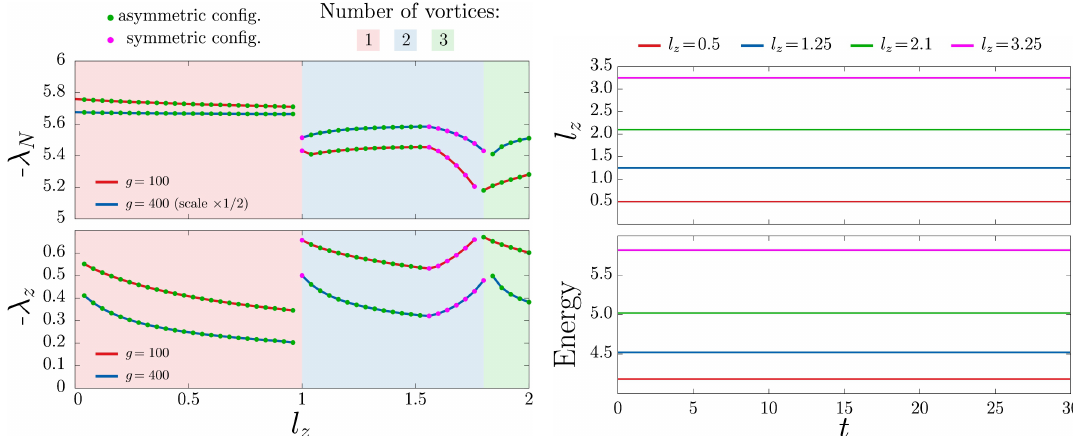
Figure 5 . Details of the results of simulations where the particle number is N = 1 . The dependence of the Lagrange multipliers on the constrained angular momentum l z are displayed on the leftmost panel. The right panels illustrate that the time-evolution algorithm (C.15) used here indeed pre- serves the energy (bottom), the angular momentum (top) and the particle number (not